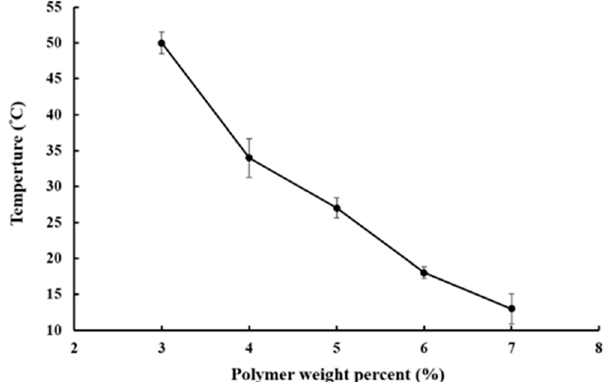
Figure 2. Sol–gel transition profile of aqueous solutions of P–Lys–Ala–PLX.